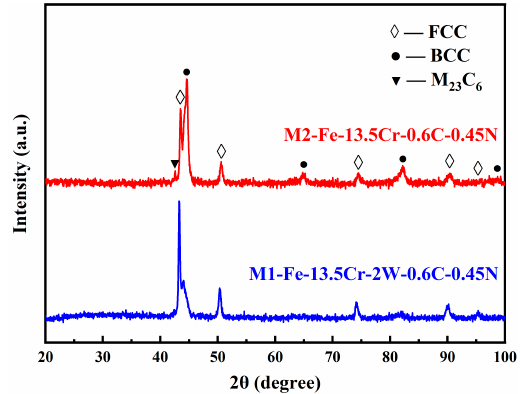
Figure 11. XRD patterns of specimens M1 and M2. Table 5. Different cooling rates and phase structures of specimens at RT.